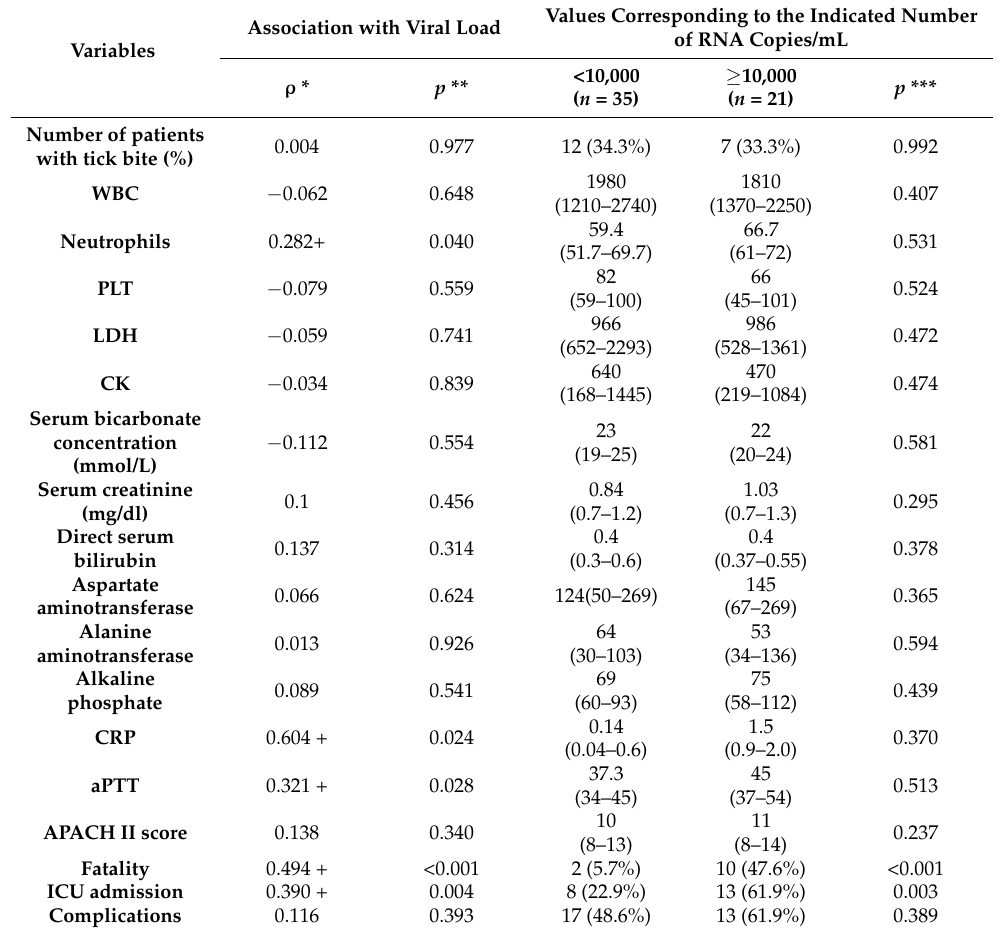
Values Corresponding to the Indicated Number of RNA Copies/mL ≥ 10,000 <10,000 p *** ( n = 35) ( n = 21)